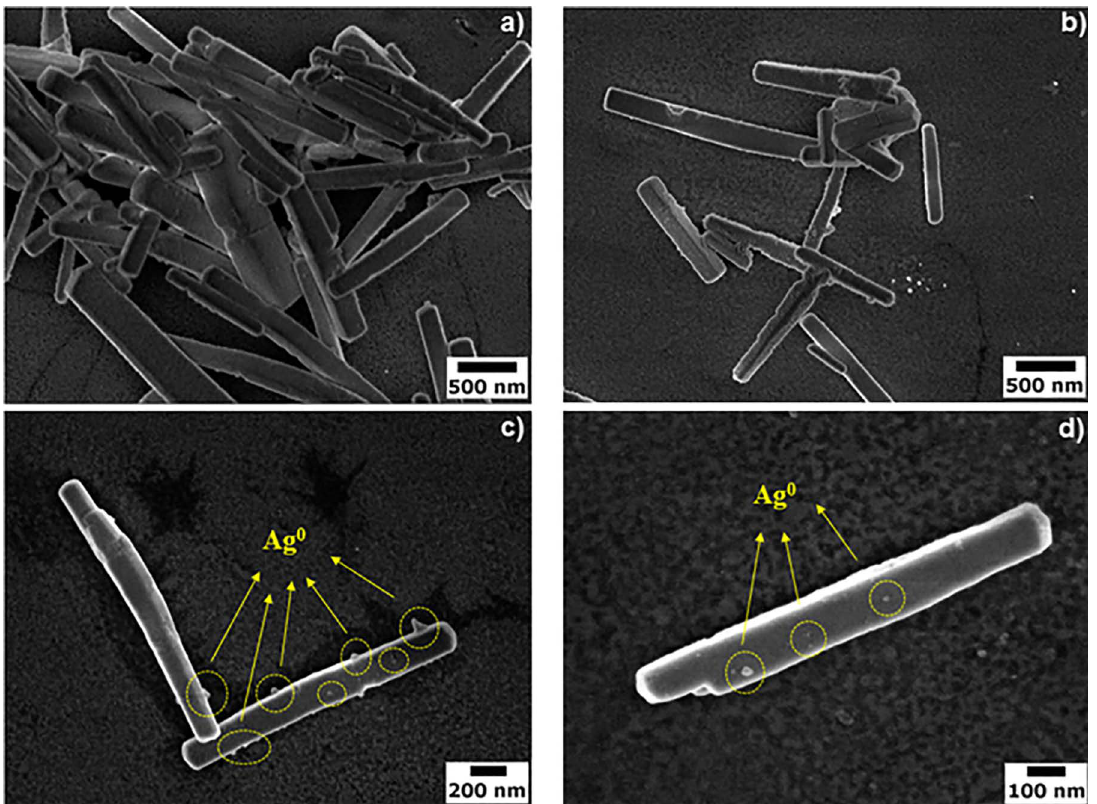
WO nanorods processed by the MAH method at 160 ºC for 1h. 2 4